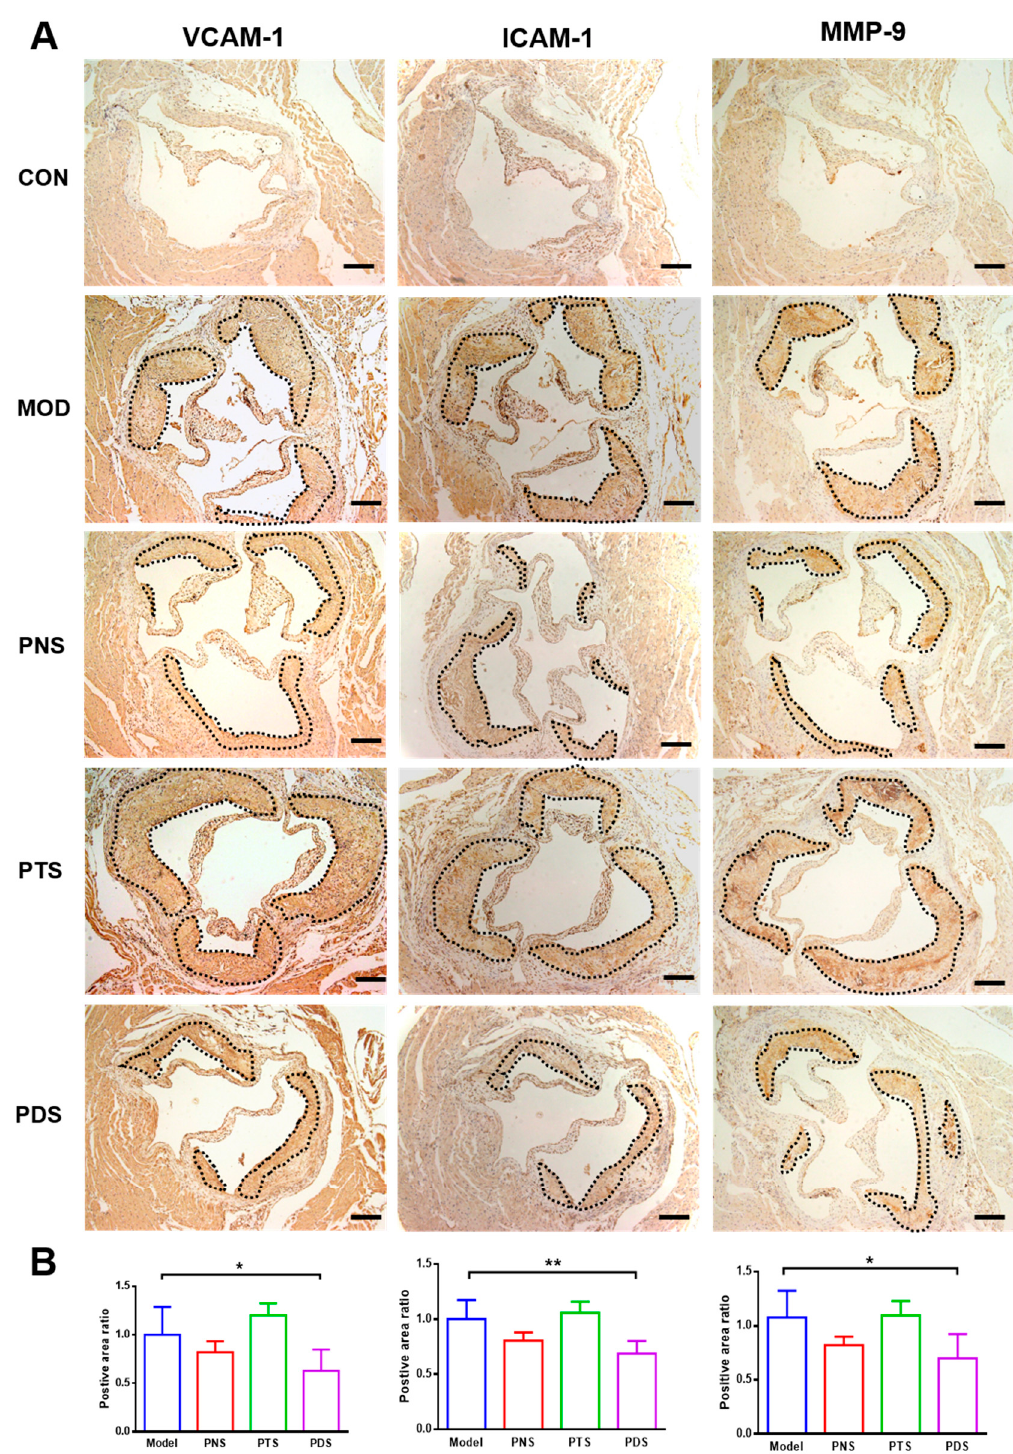
Figure 7. Immunohistochemical staining of VCAM-1, ICAM-1, and MMP-9 in cross sections of the aortic sinus ( A ) and corresponding quantifications ( B ). The stained area was cycled by black dash lines. Scale bar, 200 µ m. Data were presented as mean ± SD (n = 5–7). *, p < 0.05; **, p < 0.01. Additionally, to examine whether the saponin fraction affects the expression of inflammation-